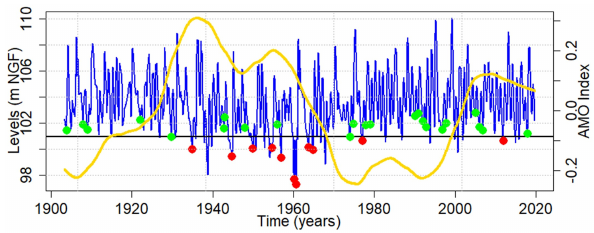
Figure 16. Same as Fig. 10 but only for the Tincques’ GWL filtered of both ∼ 7-year (MAV) and ∼ 17-year (DV) components, with the Atlantic Multidecadal Variability (AMV) index superimposed in yellow. The AMV is smoothed to highlight the multidecadal vari-